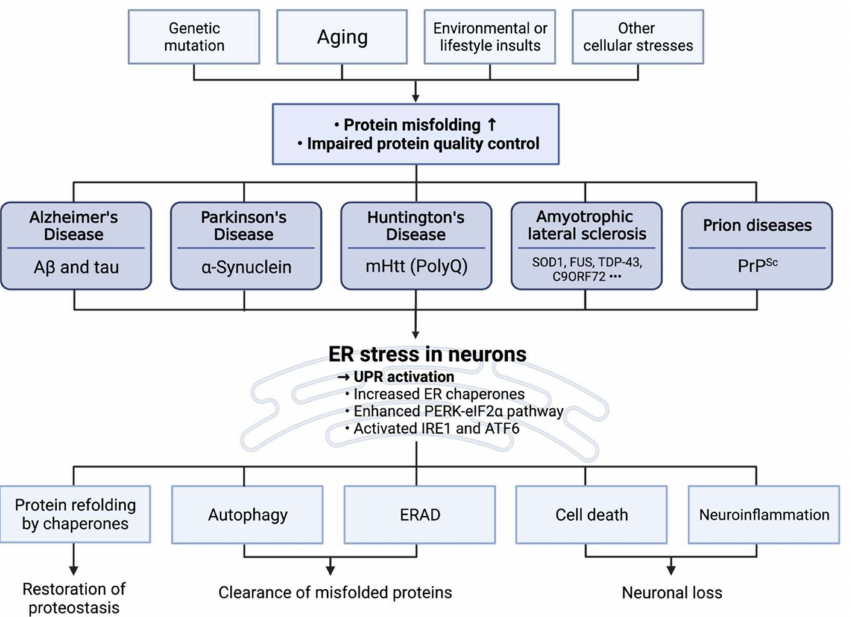
Figure 3. ER stress and neurodegeneration triggered by misfolded protein aggregates. Genetic mutations, aging, environmental insults, and various cellular stresses disrupt ER protein quality control and proper folding of proteins. Increased protein misfolding induces ER stress and accelerates the accumulation of disease-associated protein aggregates. ER chaperone activities and UPR pathways are enhanced as adaptive stress responses to alleviate ER stress. As a result, various chaperones and protein clearance mechanisms such as autophagy and ERAD contribute to refolding or eliminating misfolded proteins. However, when sustained ER stress in the neuron exceeds the capacity of adaptive responses to cope with protein misfolding, ER stress can lead to neuronal cell death and neuroinflammation, contributing to the development of neurodegenerative